Question: In a single sentence, describe what this figure presents.
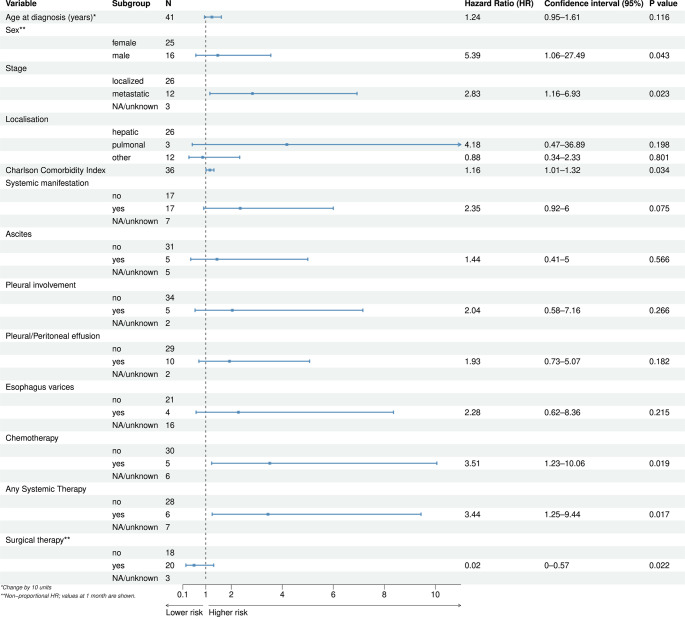
Answer: Forest plot of progression free survival (PFS). Cox regression–derived hazard ratios with 95% confidence intervals